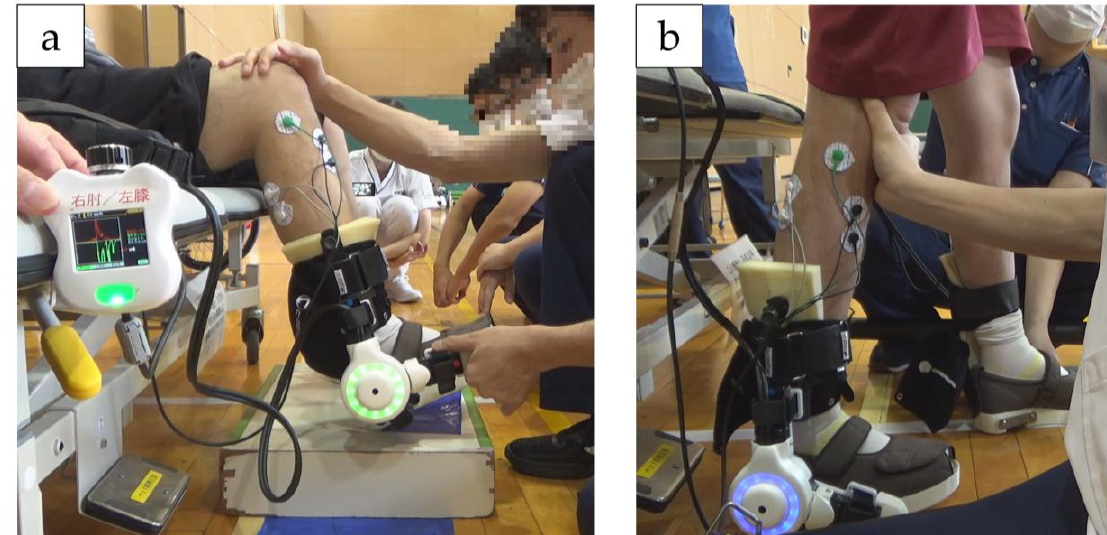
Figure 2. ( a ) Ankle joint plantar dorsiflexion exercises with HAL-SJ in end-sitting position. ( b ) Step- ping exercises with HAL-SJ. During squat and stepping exercises, a harness was used to prevent falls and partial unloading.